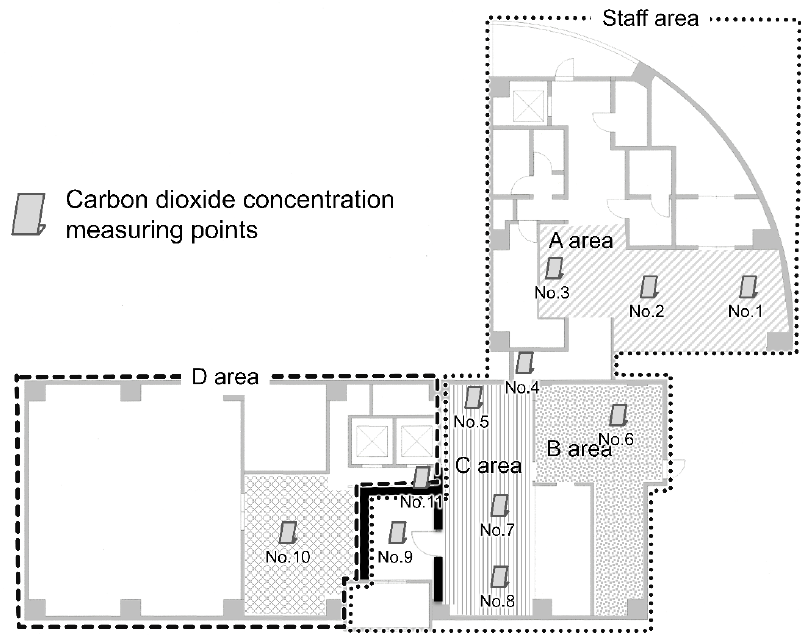
Figure 2. Installation position of the carbon dioxide measuring points.